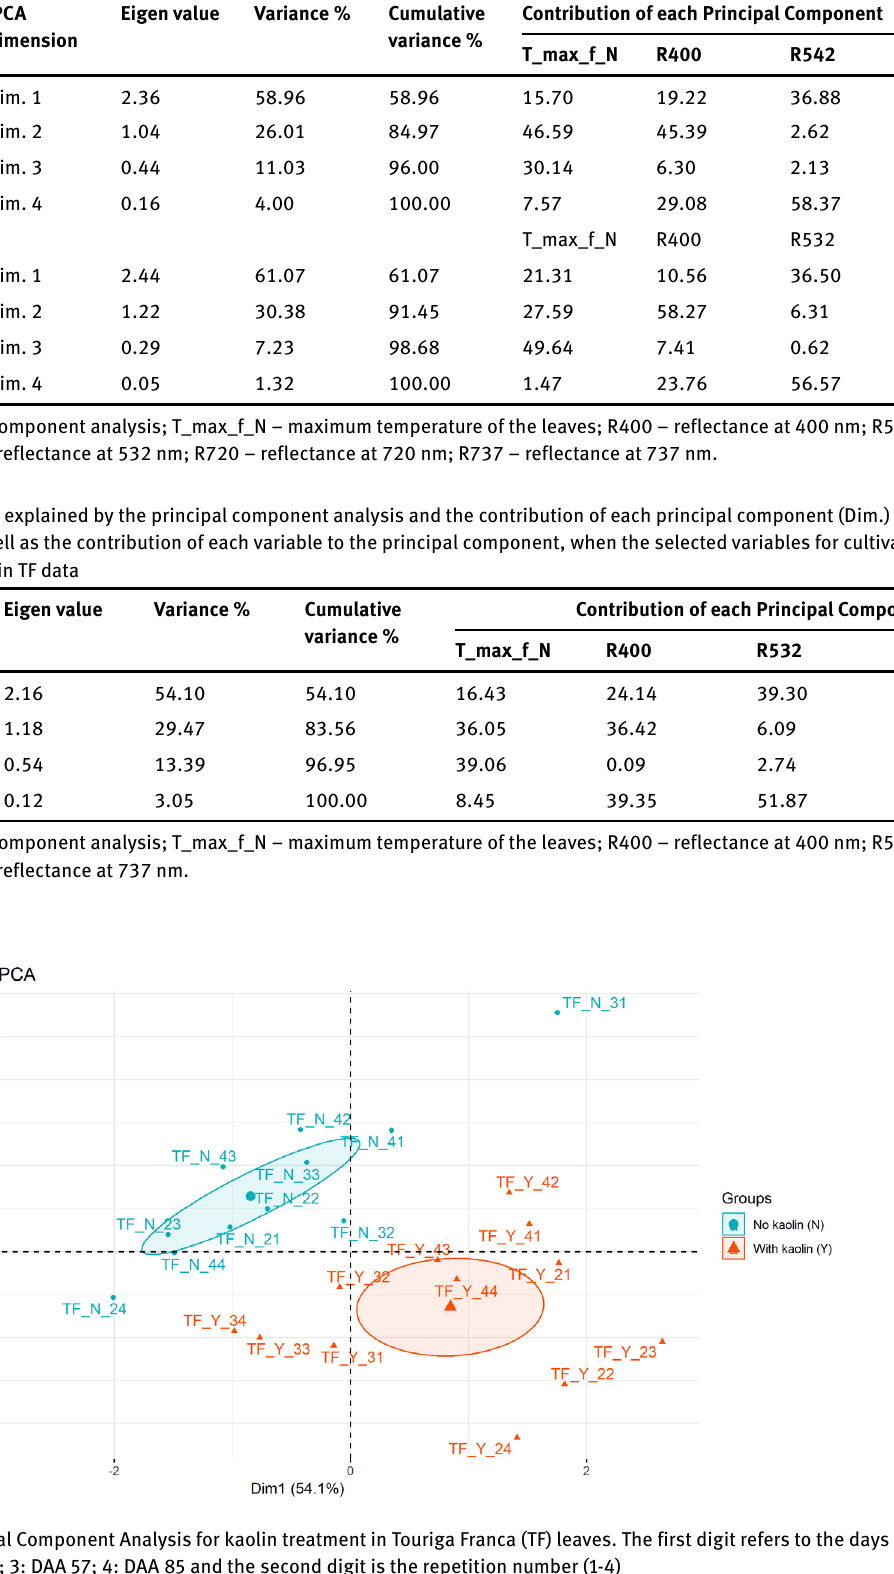
Table 2: Variance explained by principal component analysis and the contribution of each principal component (Dim.) for Touriga Franca (TF) and Touriga Nacional (TN) as well as the contribution of each variable to the principal component Varities